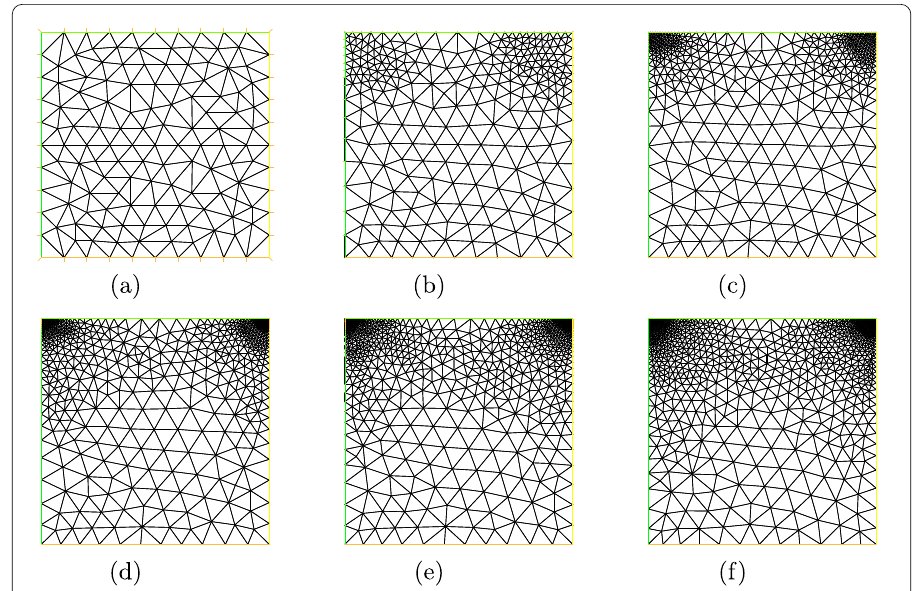
Figure 5 Adaptive refinements by P 1 – P 0 stabilized method for the cavity flow with slip boundary condition: g = 1.0. ( a ): T 1 ; ( b ): T 2 ; ( c ): T 3 ; ( d ): T 4 ; ( e ): T 5 ; ( f ): T 6